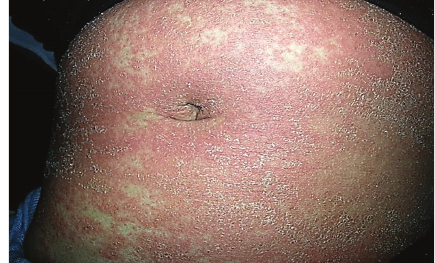
Figure 1: Revealed pustules on erythematous areas that tended to unite and did not display a follicular localization on the abdomen.